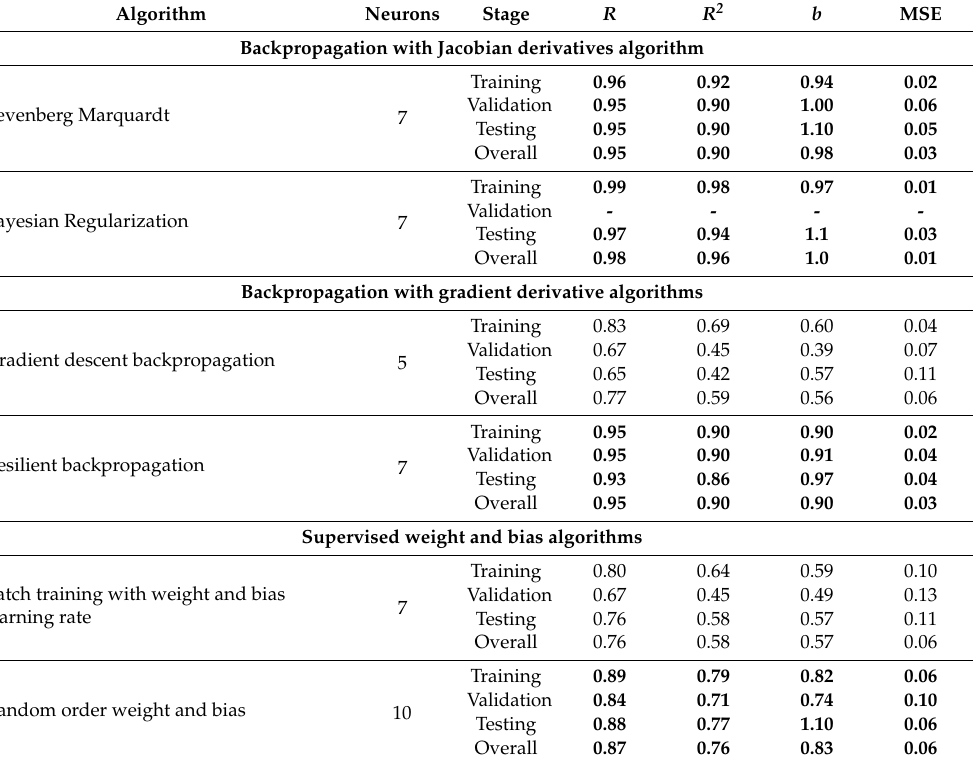
Table 3. Statistical results of the best and worse models developed using the algorithms from the three di ff erent groups. Numbers in bold represent the models with the highest correlation and determination coe ffi cients from each group of algorithms. Algorithm Neurons Stage R R 2 MSE Backpropagation with Jacobian derivatives